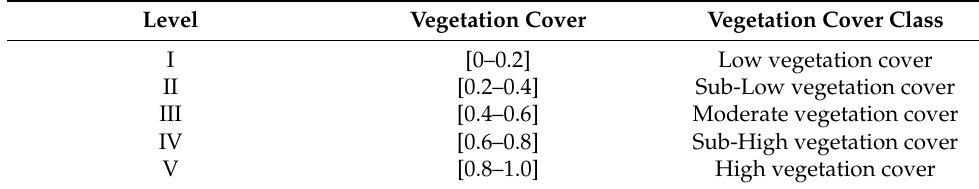
Table 1. The vegetation cover class classification